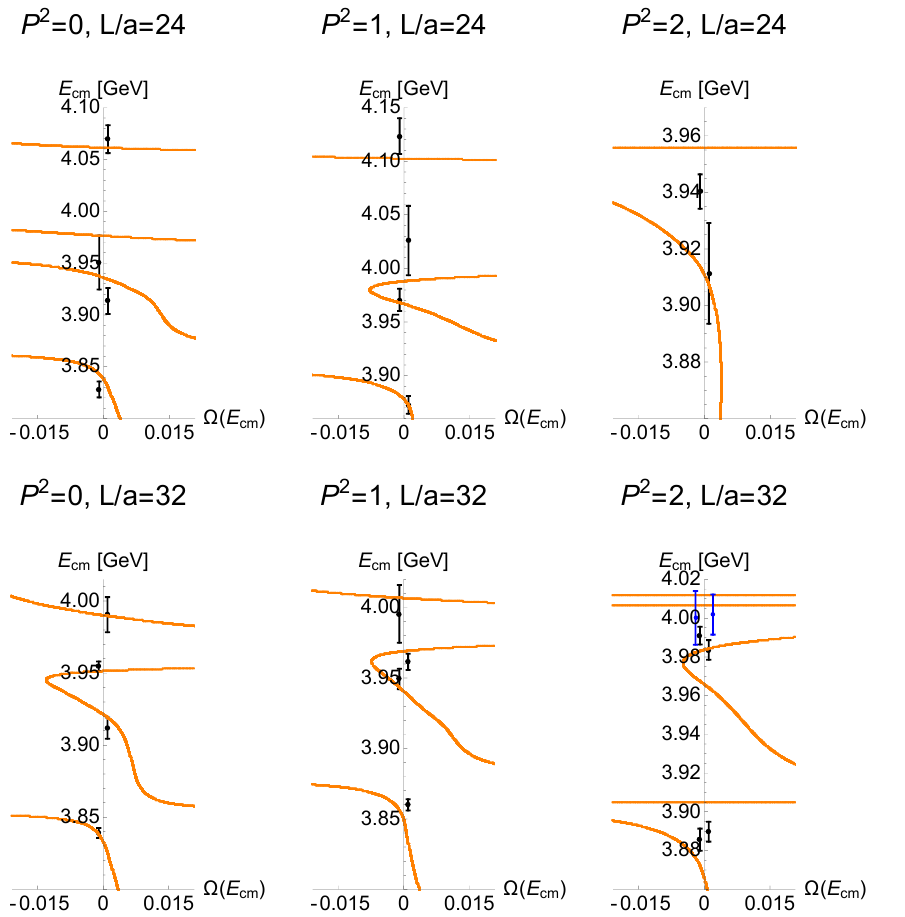
Figure 16 . The Ω( E cm ) function (defined in eq. (C.1)) for the scattering matrix of the coupled channels D ¯ D − D s ¯ D s in the wider energy region ( E cm ’ 2 m D − 4 . 1 GeV) is given by the orange line. The observed eigen-energies are given by circles and the coloring is the same as in figure